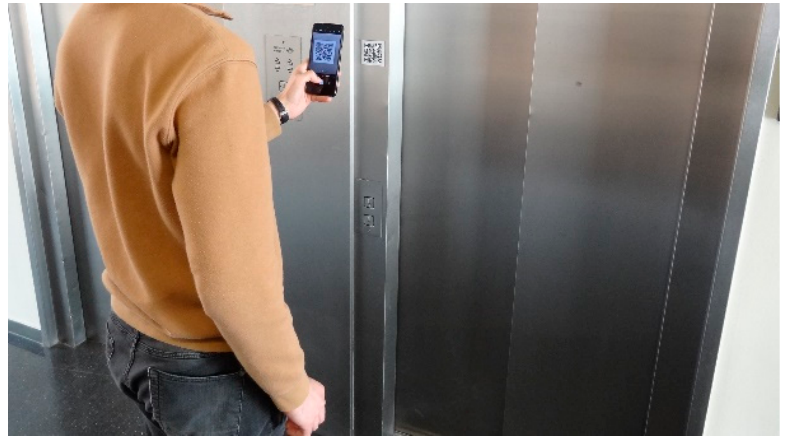
Figure 15. User with a mobile phone reading the QR code (at 0.3 m) to call the elevator.